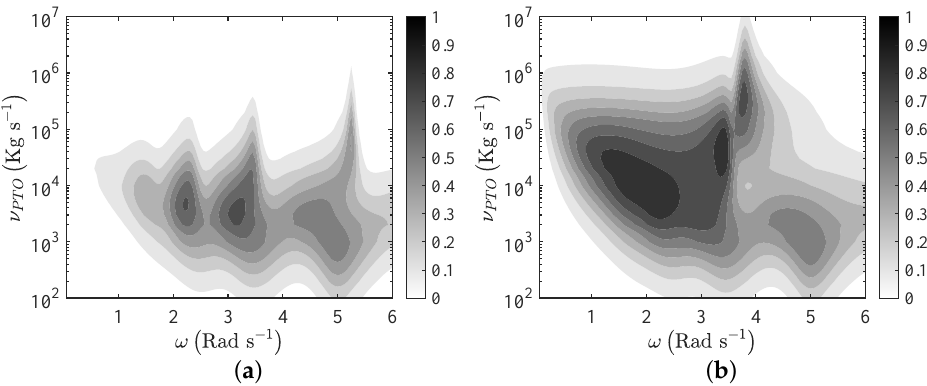
Figure 4. Behaviour of the Capture Factor versus frequency of the incident waves and PTO-Coefficient. ( a ) PTO at the ends x i = ± L ; ( b ) Equally spaced PTO every 5